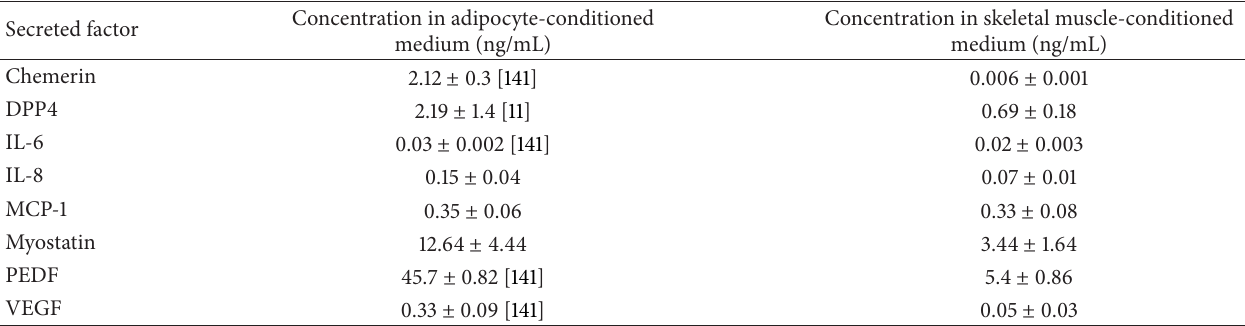
Associated with insulin resistance/T2D ✓ IL-6 promotes insulin resistance [91, 98, 99] n.d. n.d. ✓ IL-8 plasma levels correlate with measures of insulin resistance [97, 179] ✓ Promotes insulin resistance [12, 129] ✓ PEDF serum levels associated with insulin resistance [180–183], PEDF promotes insulin resistance [141]